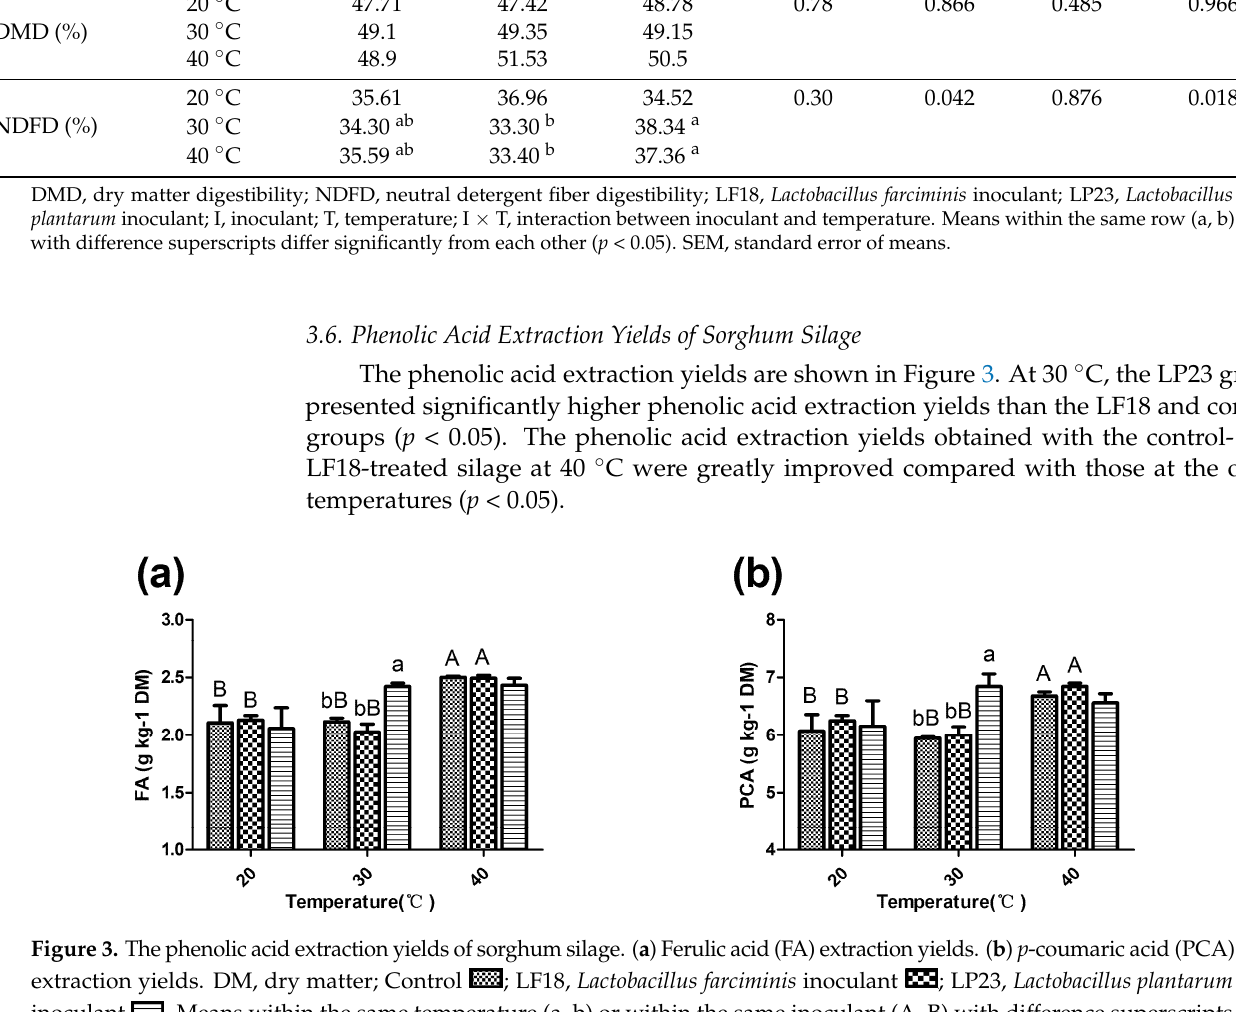
Figure 2. The Flieg’s point of sorghum silage. Control ; LF18, Lactobacillus farciminis inoculant ; LP23, Lactobacillus plantarum inoculant . Means within the same temperature (a, b) or within the same inoculant (A, B) with difference superscripts differ significantly from each other ( p < 0.05). Error bars indicate standard error of means.